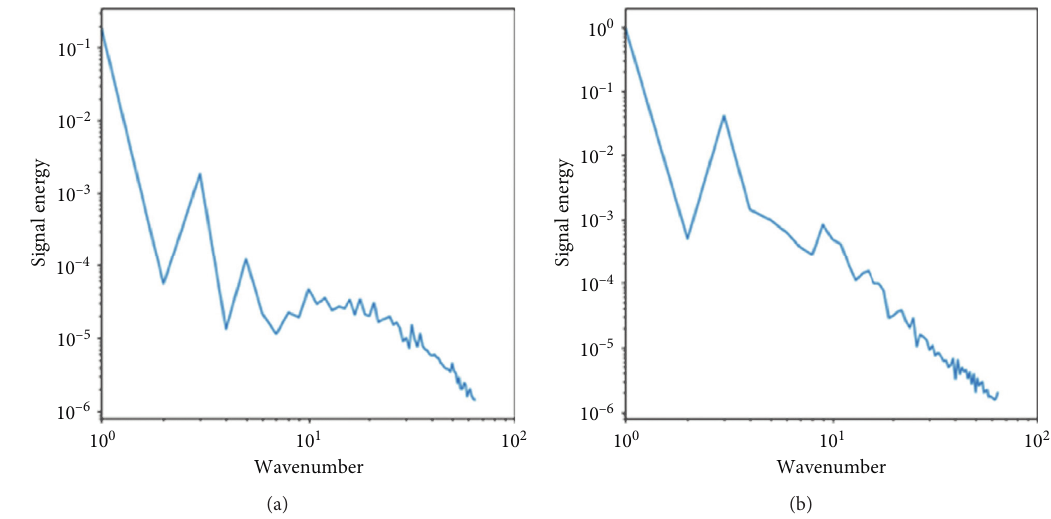
Figure 5: Energy spectra of the temperature standard deviation at (a) 500hPa and (b)